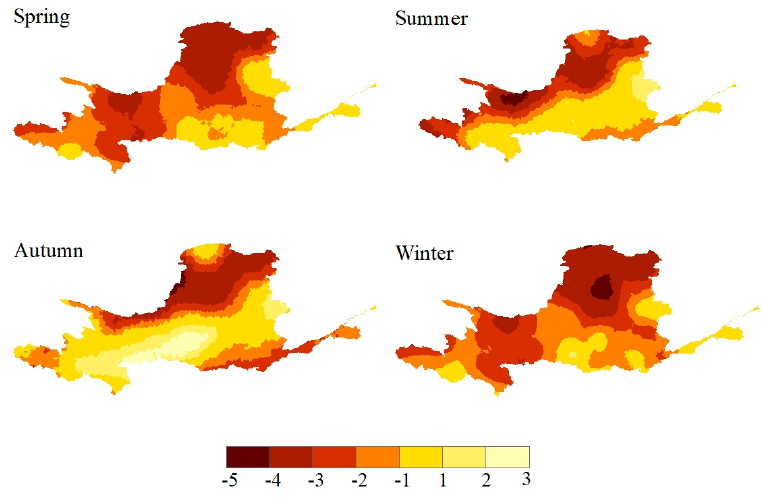
Figure 3. The spatial distribution of average seasonal sc − PDSI in the YRB.